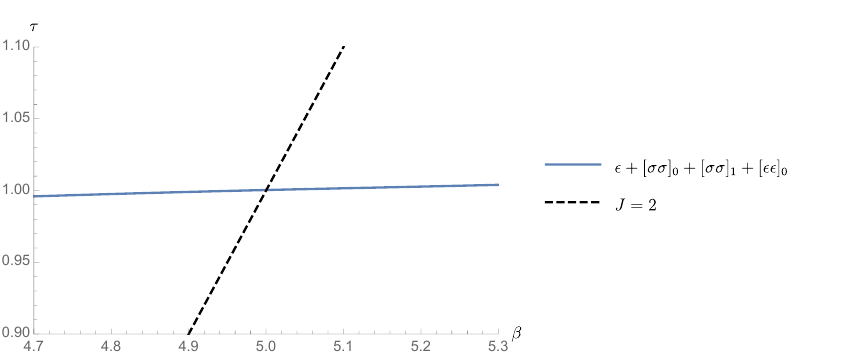
(a) Evaluated at z = 10 − 4 , (b) Evaluated at z = 10 − 3 . Figure 7 . Individual high twist operators 2 z∂ z C τ 0 ,j 0 ( z,β ) − 2∆ σ push the curve of γ β =5 down. C τ 0 ,j 0 ( z,β )